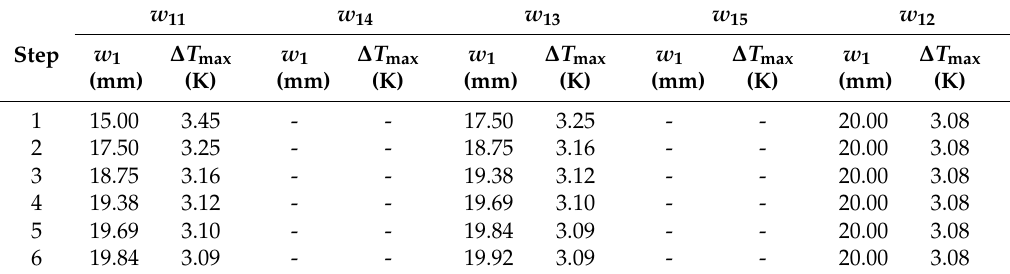
Table 10. The process of the optimization of w 2 ( w 1 = 1.0 mm).